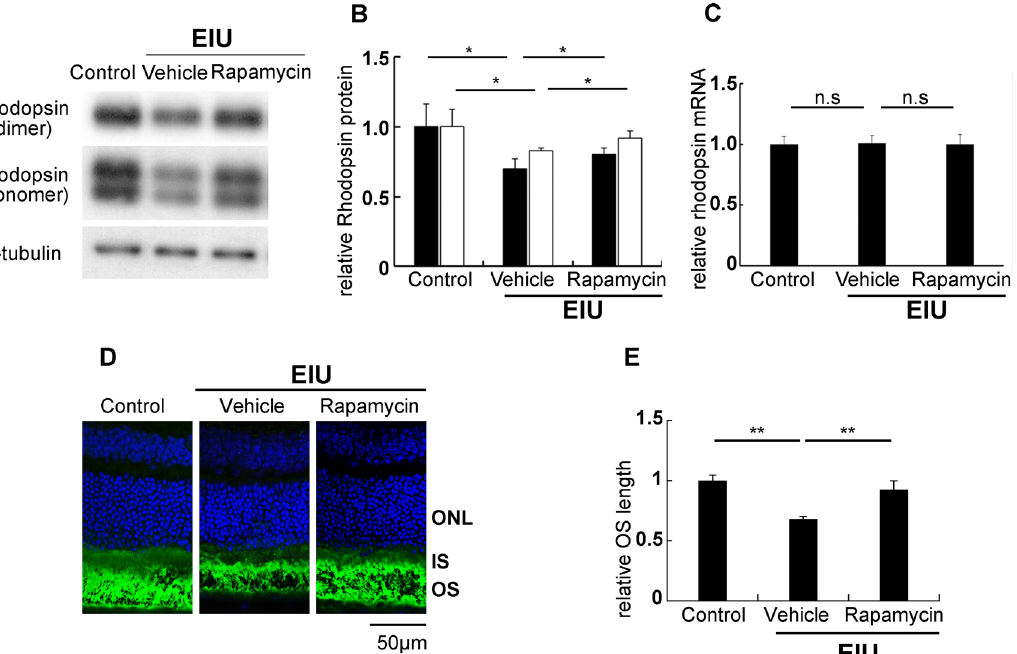
Fig 1. Rapamycin suppressed rhodopsin reduction and OS shortening during inflammation in a post-transcriptional manner. Immunoblot analysis showed that both the monomer and dimer forms of rhodopsin were reduced in the retina 24 hours after inflammation induced by an intraperitoneal injection of lipopolysaccharide (LPS), and that this reduction was attenuated by rapamycin treatment (A, B; monomer, black bars; dimer, white bars). Real-time PCR showed that the rhodopsin mRNA level was not changed in the retina during inflammation in the presence or absence of rapamycin at the same time points (C). Immunohistochemical staining for rhodopsin (green) showed that reduction of the photoreceptor outer segment (OS) length in the retina during inflammation was suppressed by rapamycin (D, E). Nuclei were counterstained with DAPI (blue). Scale bar, 50 μ m. (A-C) n = 5; (D, E) n = 4. * p < 0.05.